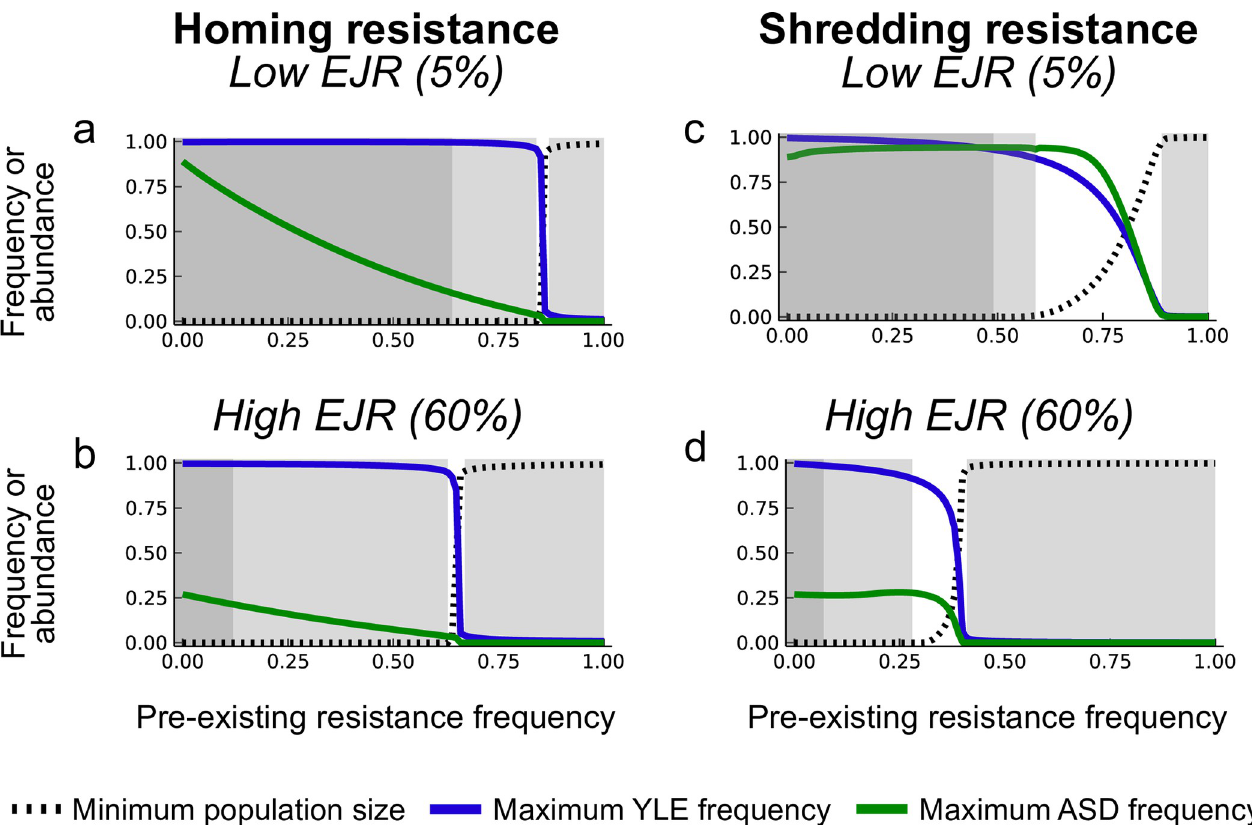
Fig 5. Exploiting pre-existing sequence differences to restrict population impact. Minimum population size and maximum construct frequencies as a function of the frequency of pre-existing resistance at the sites of homing and shredding for low and high EJR scenarios. Simulations were run for 1000 generations with different initial frequencies of resistant alleles. In each plot the lightly shaded boxes to the left and right show regions where the minimum population size over the 1000 generations is less than 1e-6 or greater than 0.95, respectively, as would be appropriate for target and non-target populations, and the darkly shaded box to the left shows regions where the population is suppressed by at least 99% in 50 generations, and therefore control may be practicable.